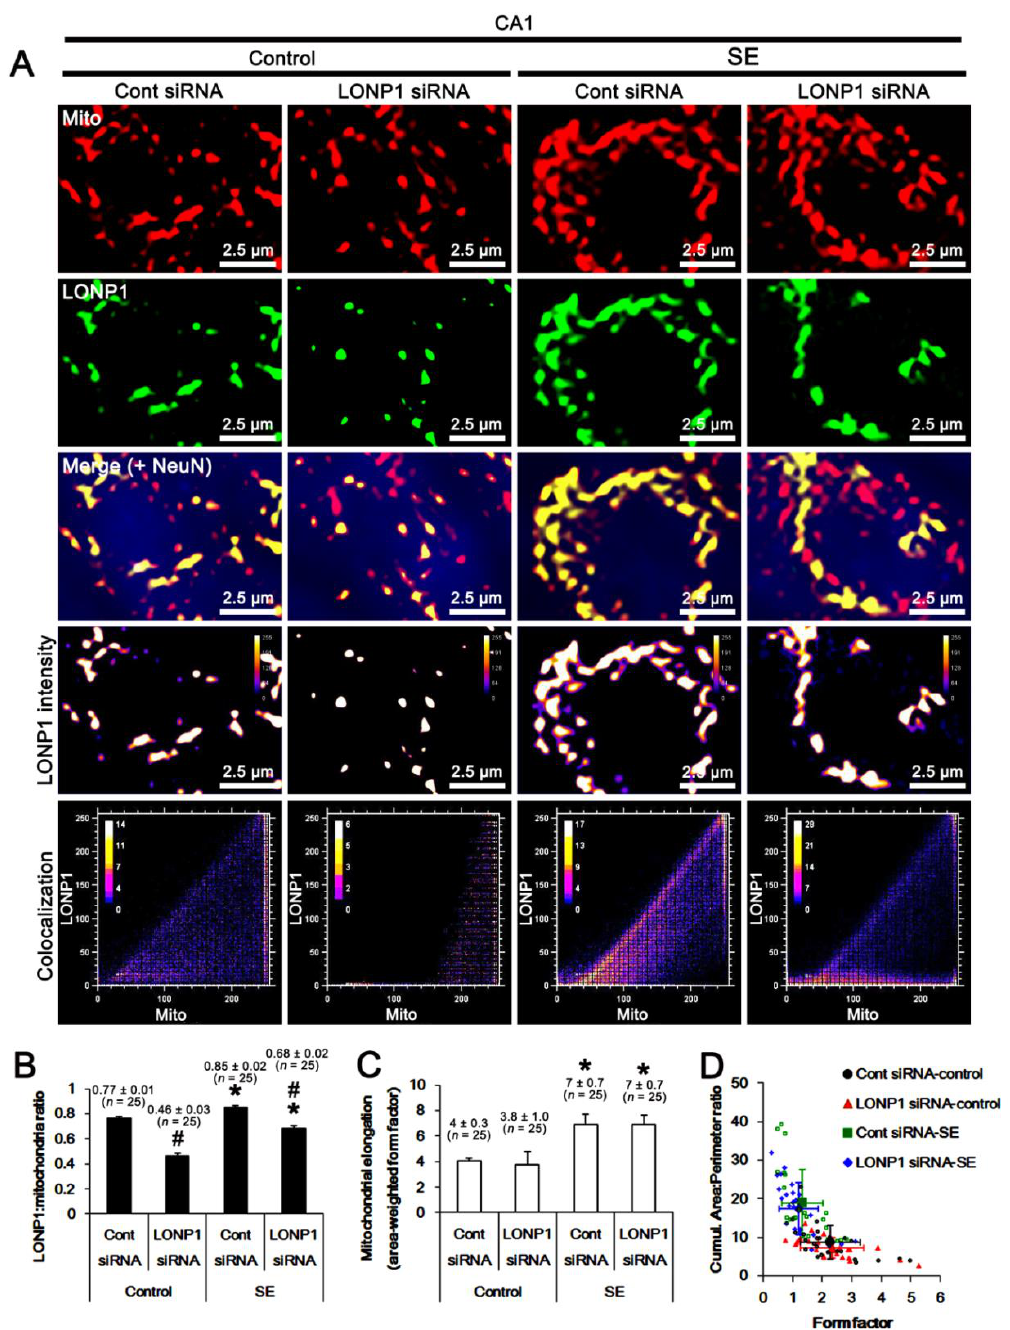
Figure 6. Effects of control siRNA and LONP1 siRNA on LONP1 expression and mitochondrial dynamics in CA1 neurons following SE. As compared to control siRNA (Cont siRNA), LONP1 siRNA decreases LONP1 protein level under physiological and post-SE conditions. ( A ) Representative photos of LONP1 expression, intensity, and the degree of colocalization in mitochondria within PV cells. ( B ) Quantification of the LONP1/mitochondria ratio following SE (mean ± S.E.M.; * ,# p < 0.05 vs. control animals and control siRNA, respectively; one-way ANOVA). ( C ) Quantification of mitochondrial elongation index following SE (mean ± S.E.M.; * p < 0.05 vs. control animals; one-way ANOVA). ( D ) Quantification of the cumulative area/perimeter ratio ( F (1,48) = 25.7, p < 0.001 vs. control animals, one-way ANOVA) and the form factor ( F (1,48) = 14.2, p < 0.001 vs. control animals, one-way ANOVA) following SE. LONP1 knockdown does not affect the cumulative area/perimeter ratio and the form factor in CA1 neurons under physiological and post-SE conditions. Each small and open symbol represents average shape metrics from one neuron ( n = total 25 cells in each group). Large and filled symbols are population averages from each group (mean ± S.D.; n = 5).